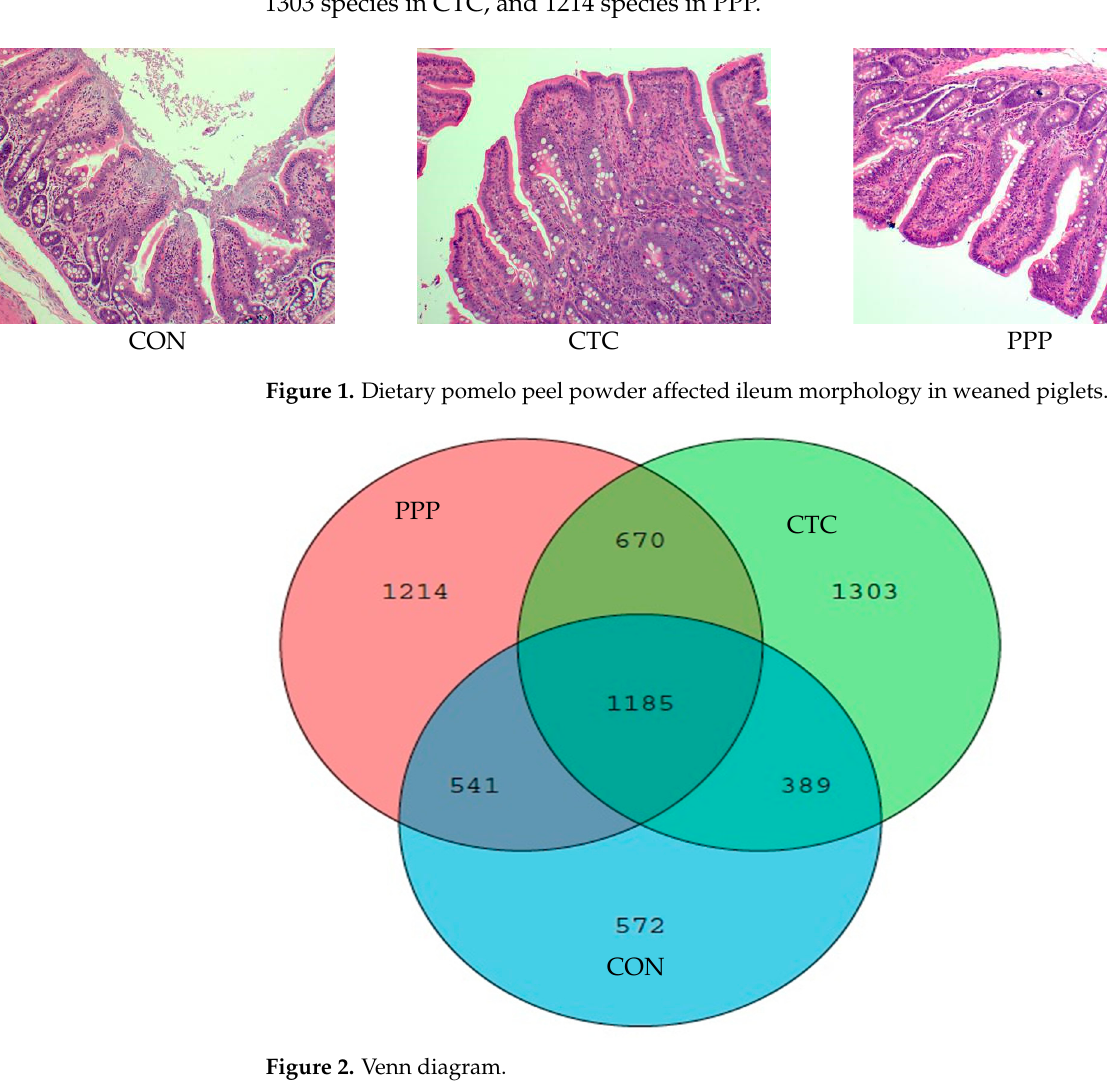
Figure 2. Venn diagram.